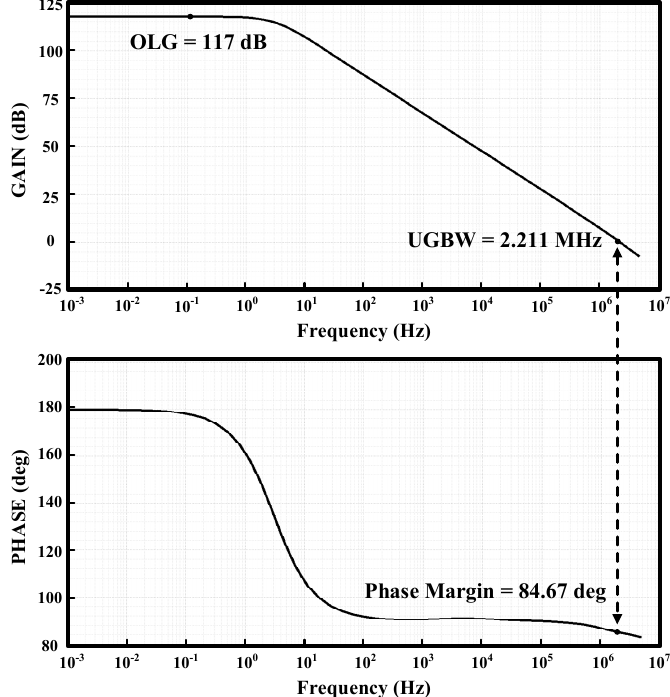
Figure 12. Stability simulation result of proposed TIA. The input referred noise simulation results are shown in Figure 13. The input referred current noise at 1 Hz is reduced from 13.2775 pA/ √ Hz to 936 fA/ √ Hz by the chopper operation. The input-referred noise density and the integrated input-referred noise from 0.1 Hz to 1 kHz are 21.7 pA RMS , respectively.